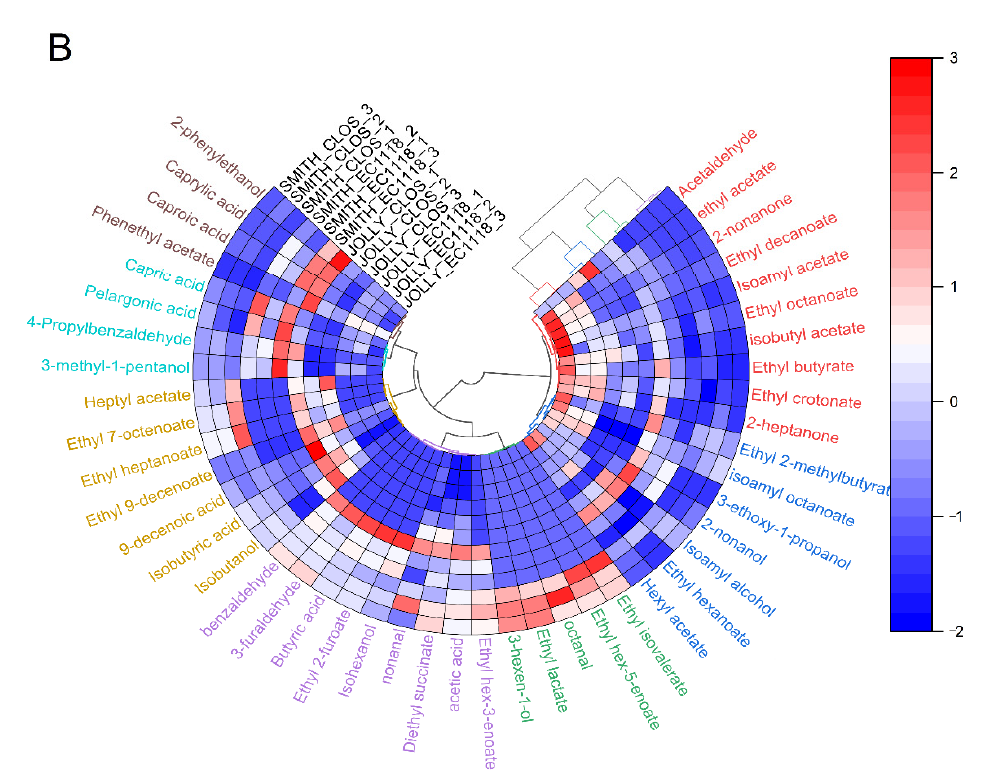
Figure 4. Results of the multivariate analysis of the volatile profiles of the pomegranate wines from the four cultivar × yeast combinations tested: biplot of the first two principal components of PCA ( A ) and polar heatmap with a circular dendrogram deriving from a hierarchical cluster analysis ( B ).